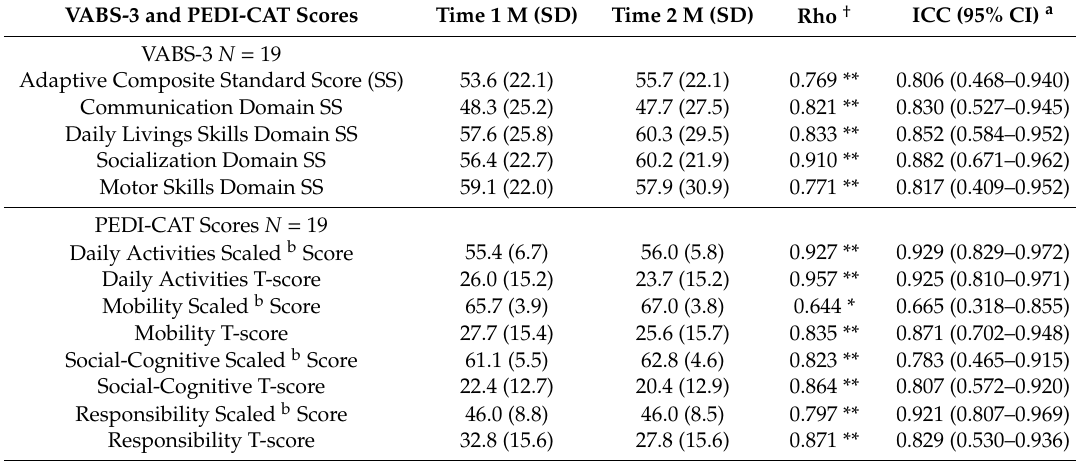
Table 5. Test-retest reliability of PEDI-CAT and VABS-3: Spearman’s rho correlations and intraclass correlation coe ffi cients